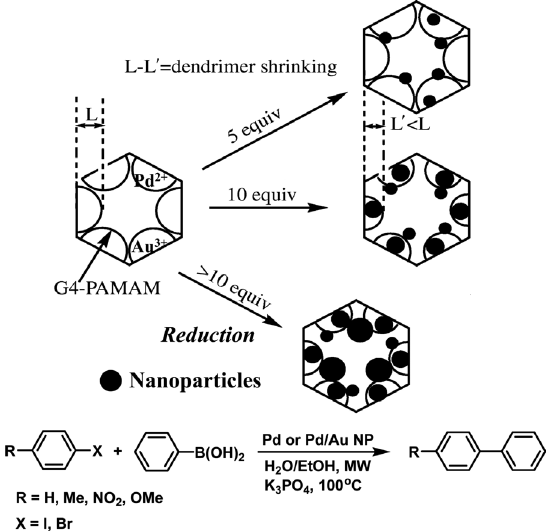
Figure 3 Procedure for the preparation of Pd and Pd/Au nanoparti- cle catalysts (top panel). Scheme of Suzuki cross-coupling reaction catalyzed by Pd or Pd/Au nanoparticles (bottom panel). Redrawn from [49].